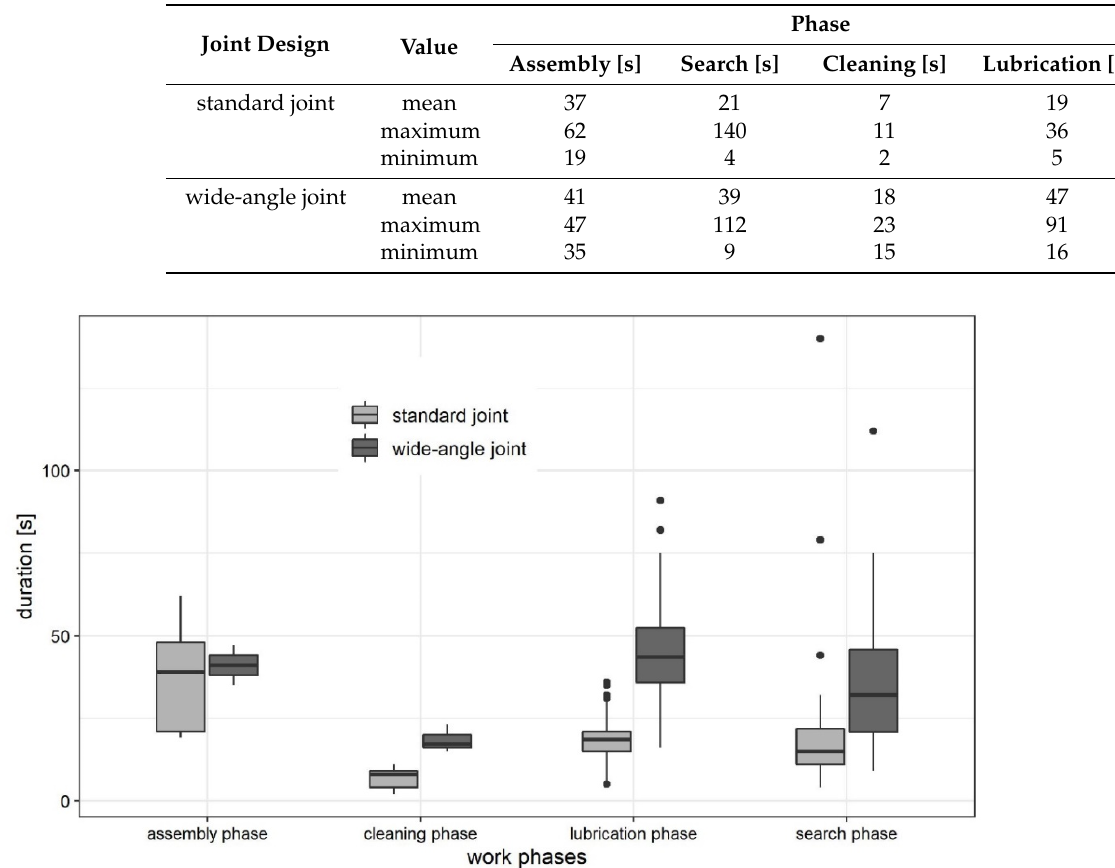
Table 2. Mean, maximum and minimum duration values of the work phases in maintaining a standard or wide-angle joint of a PTO shaft.